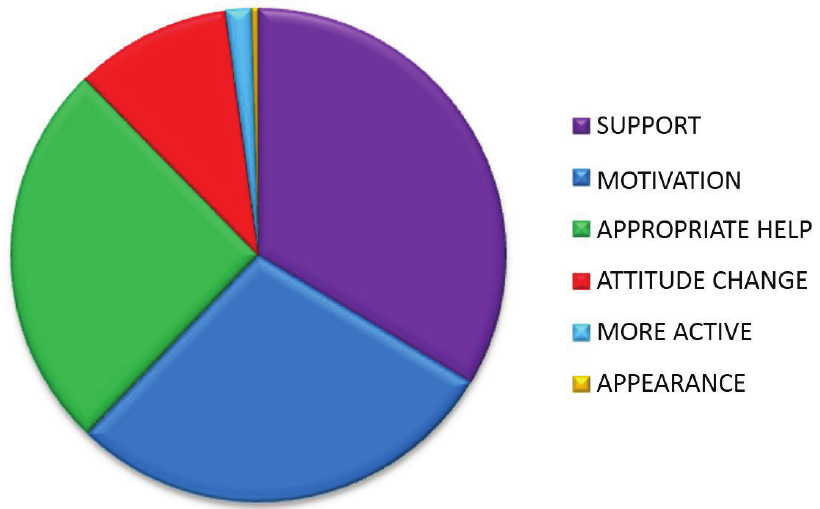
Figure 4. Proportion of reasons given by patients for feeling encouraged to lead a healthier lifestyle.